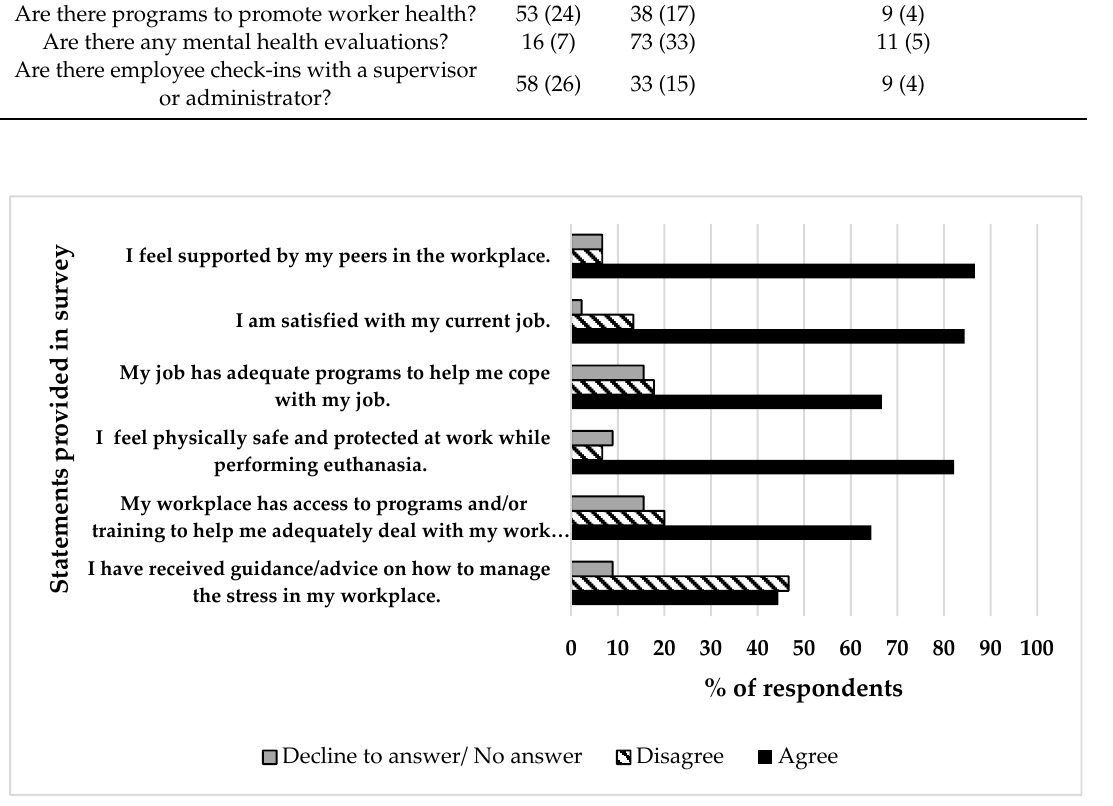
Figure 2. The level of agreement by respondents ( n = 45) with various statements regarding perceptions of the workplace. For each statement, respondents were given the following options: strongly agree, agree, disagree, strongly disagree, and decline to answer. In this figure, “Agree” represents agree and strongly agree responses and “Disagree” represents disagree and strongly disagree responses. “Decline to answer” also includes respondents that provided no selection.